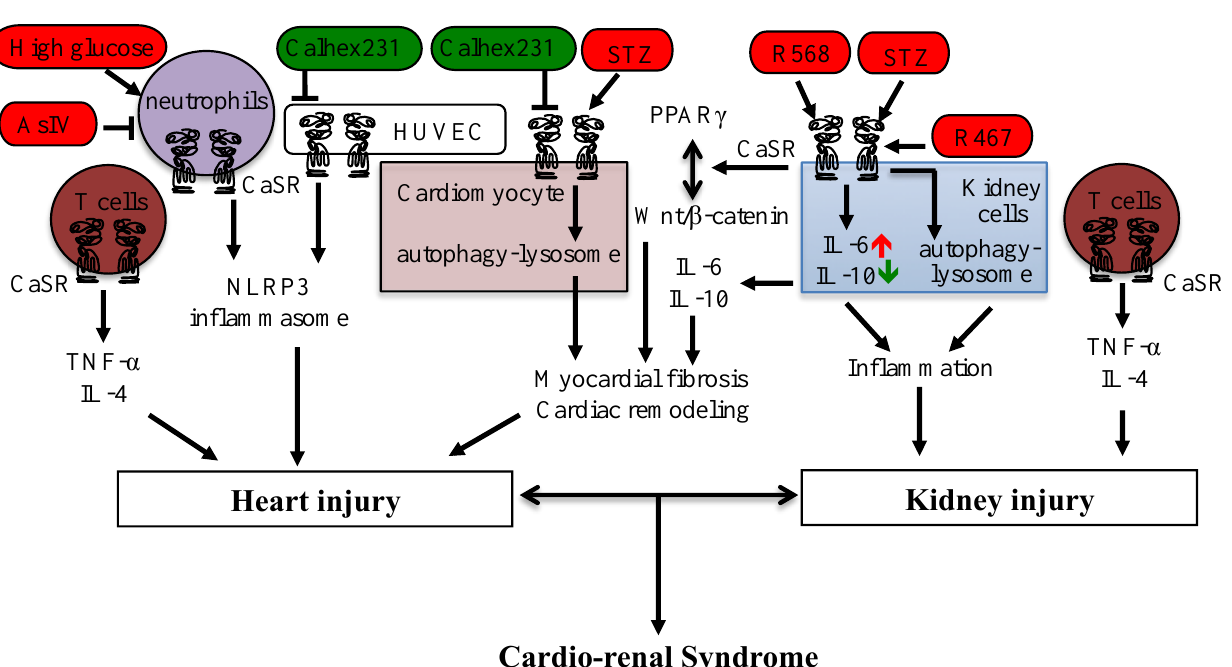
Figure 2. CaSR-mediated signaling in cardiorenal syndrome and heart – kidney interaction. The activation regulator is in red color, and the negative modulator is in green color.